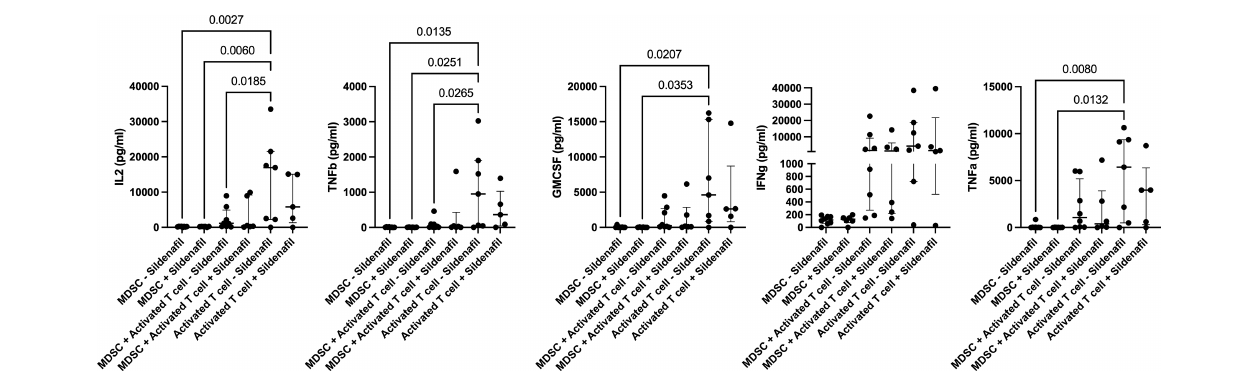
FIGURE 4 | Sildena fi l supplementation does not affect T cell or MDSC cytokine production (IL2, TNFb, GMCSF, IFNg, TNFa). Analyte concentration (pg/ml) was measured for various culture combinations (MDSC only, MDSC-T cell coculture, and T cell only), under differing stimulation combinations (Unstimulated and anti- CD3CD28 bead Activation) with or without Sildena fi l treatment, by multiplex analysis. Plots show analyte concentration in culture supernatant. One-way ANOVA with Tukey post-hoc correction. Median with interquartile range indicated on plots. P<0.05 was considered signi fi cant. Pairwise comparisons which were ns are not shown on